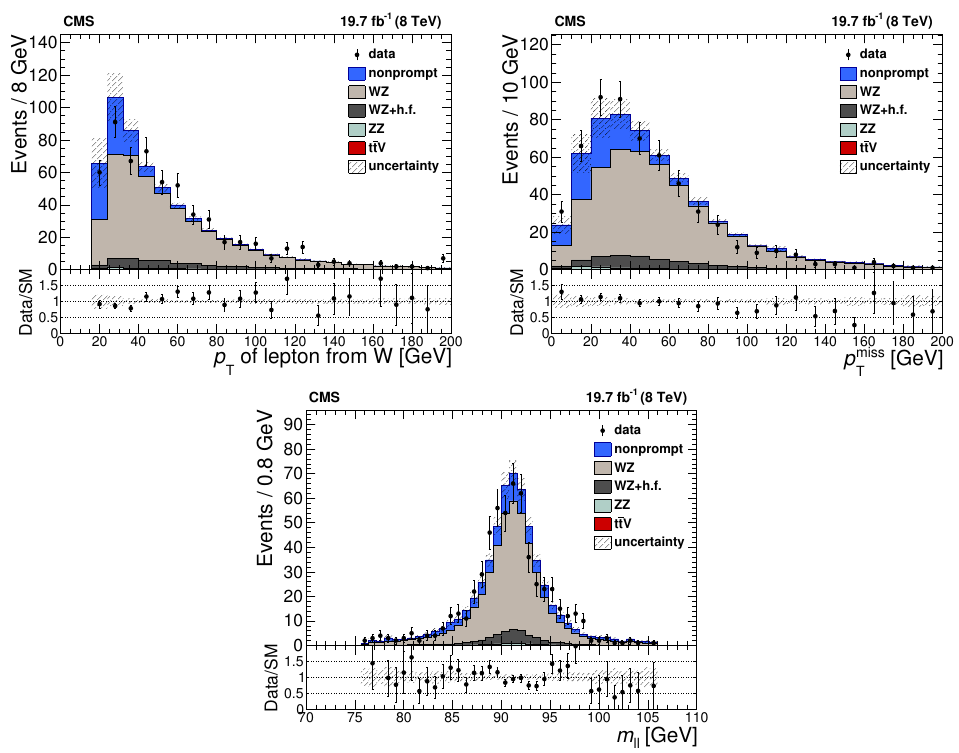
Figure 6 . Data-to-prediction comparisons in the background-enriched samples, after applying background normalisation scaling factors as described in the text, of the p T of the lepton from the W boson (top-left), p miss (top-right), and m ‘‘ (bottom). The four channels are combined. The T lower panels show the ratio between observed and predicted yields, including the total uncertainty on the prediction. The distributions shown here are for the tZ-FCNC search, where WZ + h.f. denotes WZ + heavy